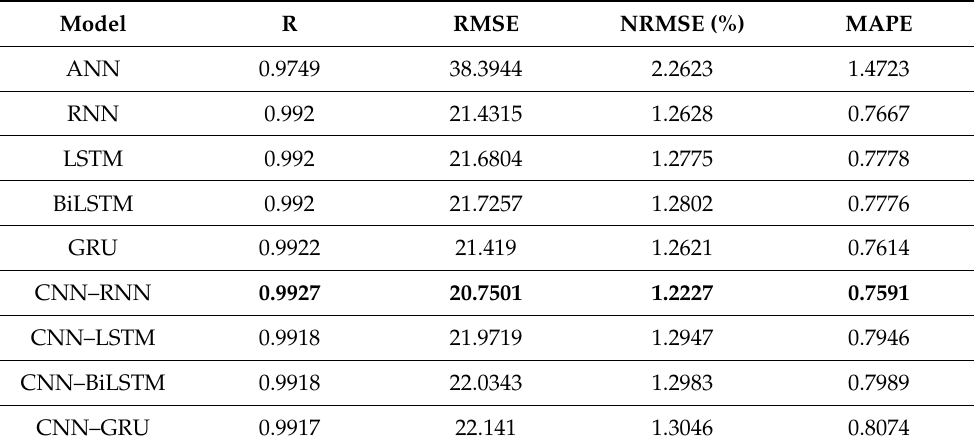
Table 3. Prediction error (R, RMSE, NRMSE, and MAPE) for the Madinah results.